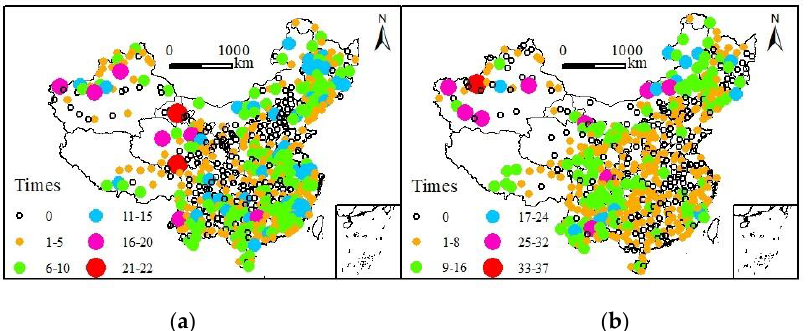
Figure 8. The spatial distribution of the total occurrence of times of extremely wet/dry events during the period 2000 – 2018 in mainland China. ( a ) Total occurrence of times of extremely wet events ( b ) Total occurrence of times of extremely dry events.